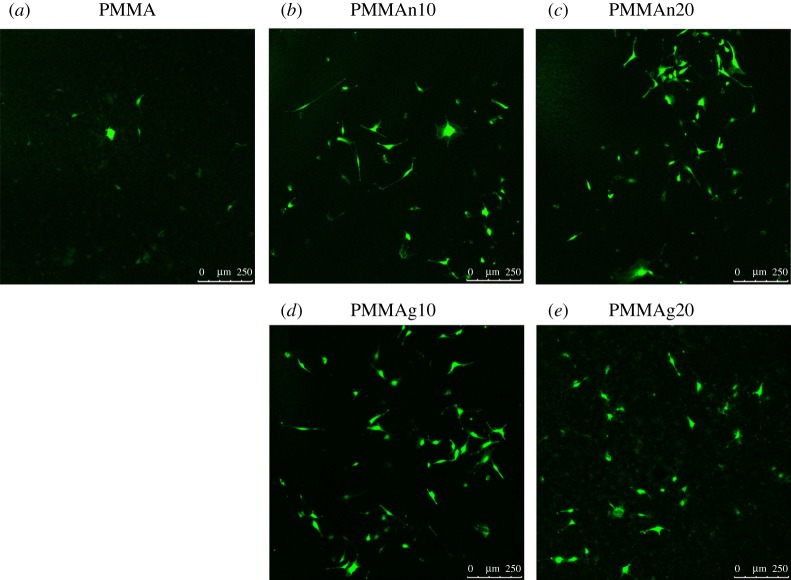
Live/dead fluorescence images of MT3T3-E1 cells (1 × 104) seeded on PMMA (a), PMMAn10 (b), PMMAn20 (c), PMMAg10 (d) and PMMAg20 (e) for 1 day. There were more live cells on the surface of PMMA-based composites with an increased loading of nHAP and gHAP.